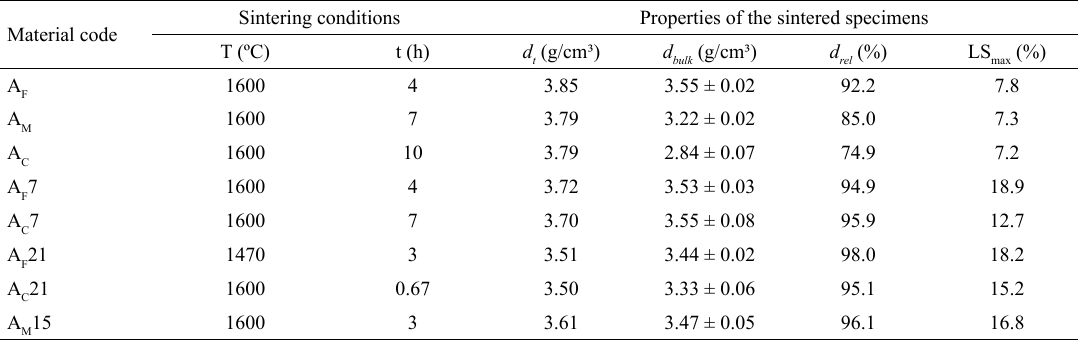
Table 3. Sintering conditions (temperature, T, and holding time, t) and properties of the sintered alumina and composites (estimated theoretical density, d , bulk density, d , relative density, d , and maximum linear shrinkage, LS t bulk rel